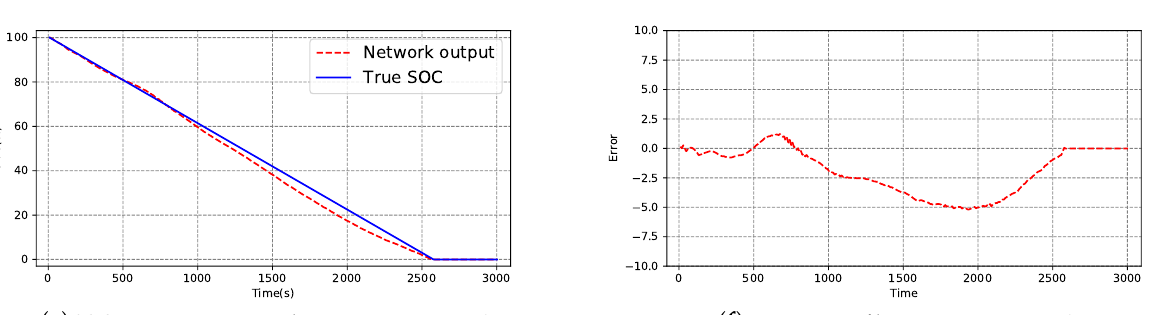
( f ) Error curve of battery capacity = 70% Figure 12. Estimation results at 25 ◦ C (2).